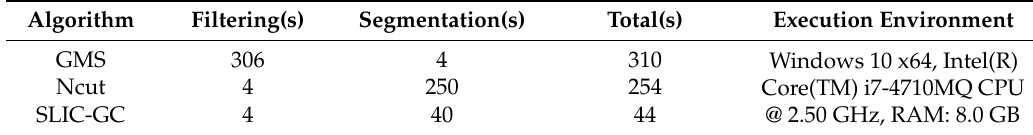
Table 4. Execution times of the different superpixel segmentation algorithms with the ESAR image.